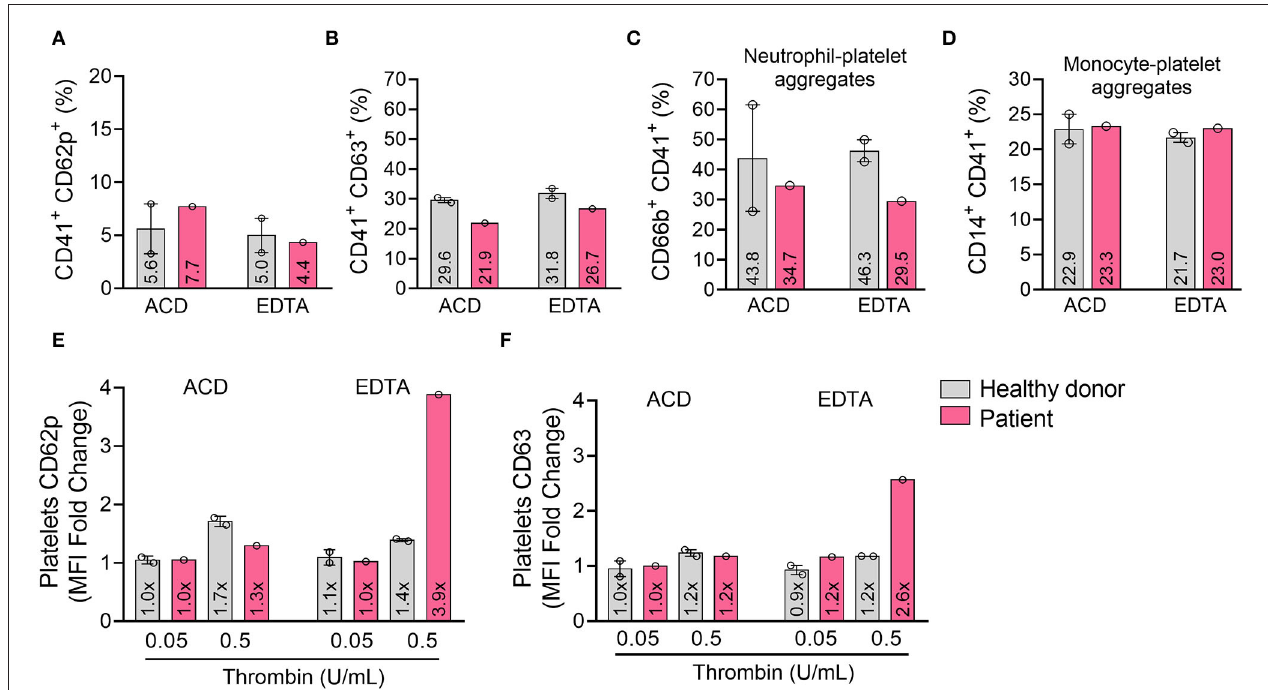
FIGURE 2 | EDTA induced platelets hyperreactivity but did not increase basal activity or heterotypic aggregation with leukocytes. Platelets were isolated from the patient and healthy donors’ fresh blood collected with ACD or EDTA and analyzed by flow cytometry for surface expression of CD62p (A) and CD63 (B) . Platelet-leukocyte aggregates were assessed by the percentage of CD41 + platelets among neutrophils (CD66b + ) (C) , total monocytes (CD14 + ) (D) , Platelet reactivity was analyzed by the mean fluorescence intensity (MFI) of CD62p (E) and CD63 (F) after stimulation with thrombin at 0.05 and 0.5 U/mL. Bars represent the mean ± SEM, and each dot represents one individual. ACD: